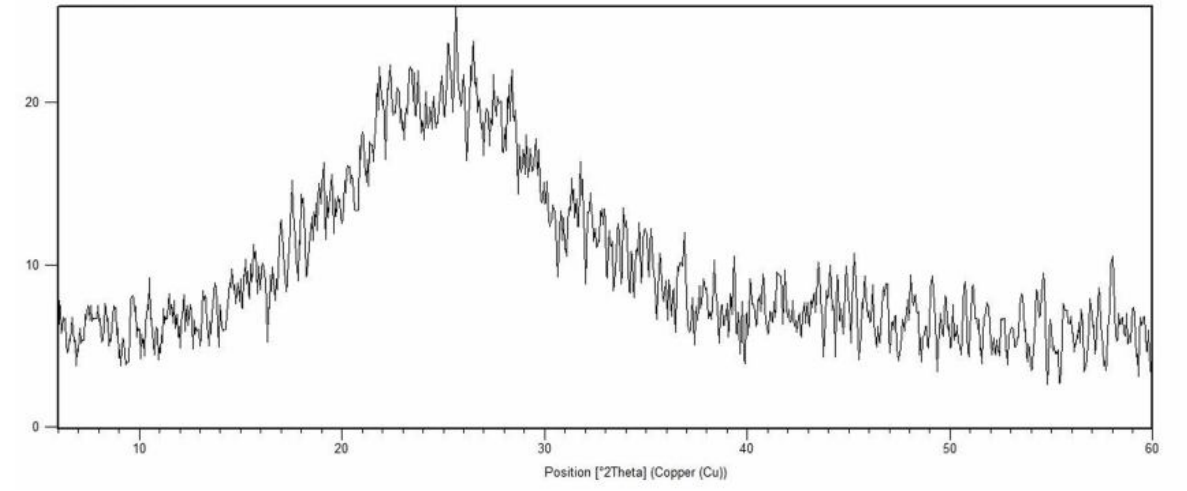
Fig. 9. X-ray diffraction pattern of the prepared perlite nanoparticles.